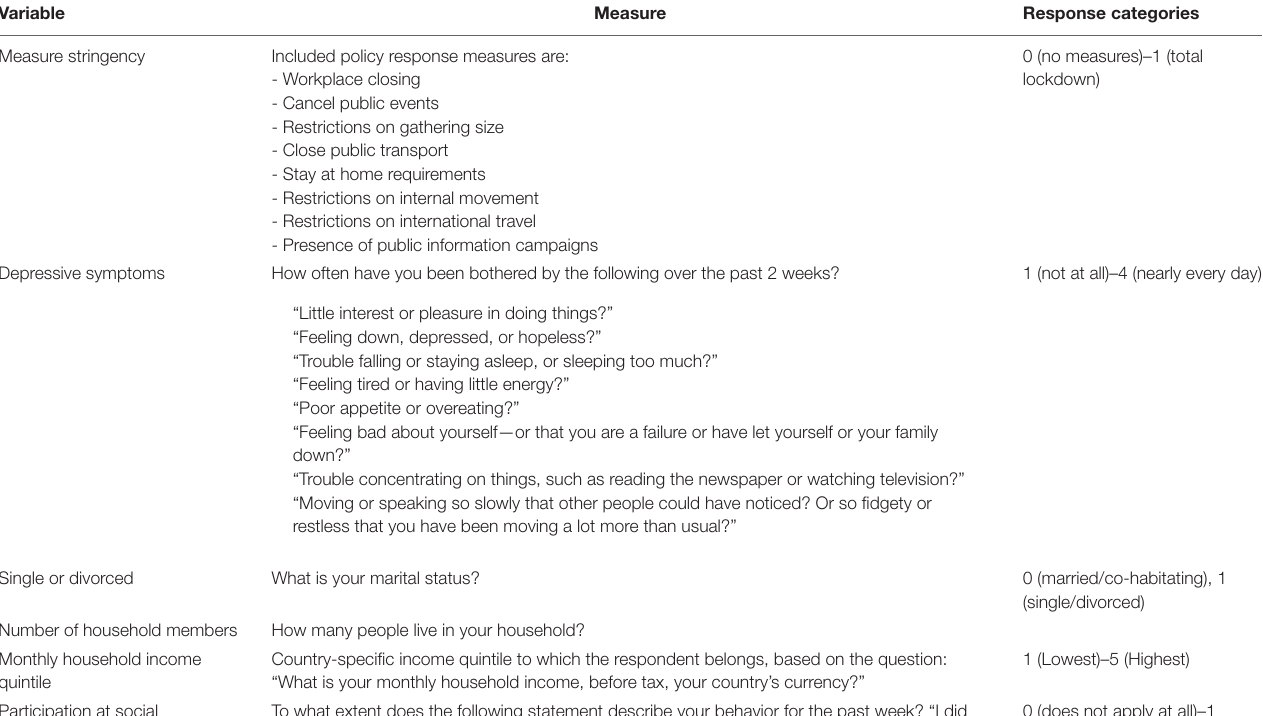
TABLE 3 | Description of